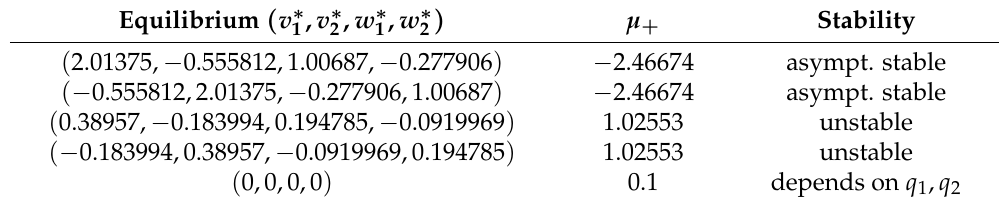
Table 1. Equilibrium states of (3) for the parameter values: a = 1.5, (cid:101) = 0.032 and β =